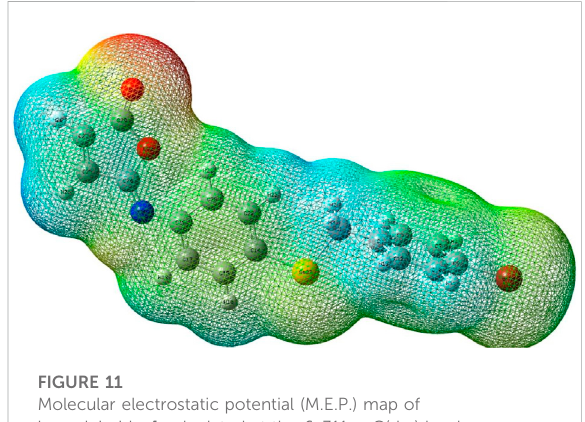
FIGURE 11 Molecular electrostatic potential (M.E.P.) map of isomaleimide 4 calculated at the 6-311++G(d,p)